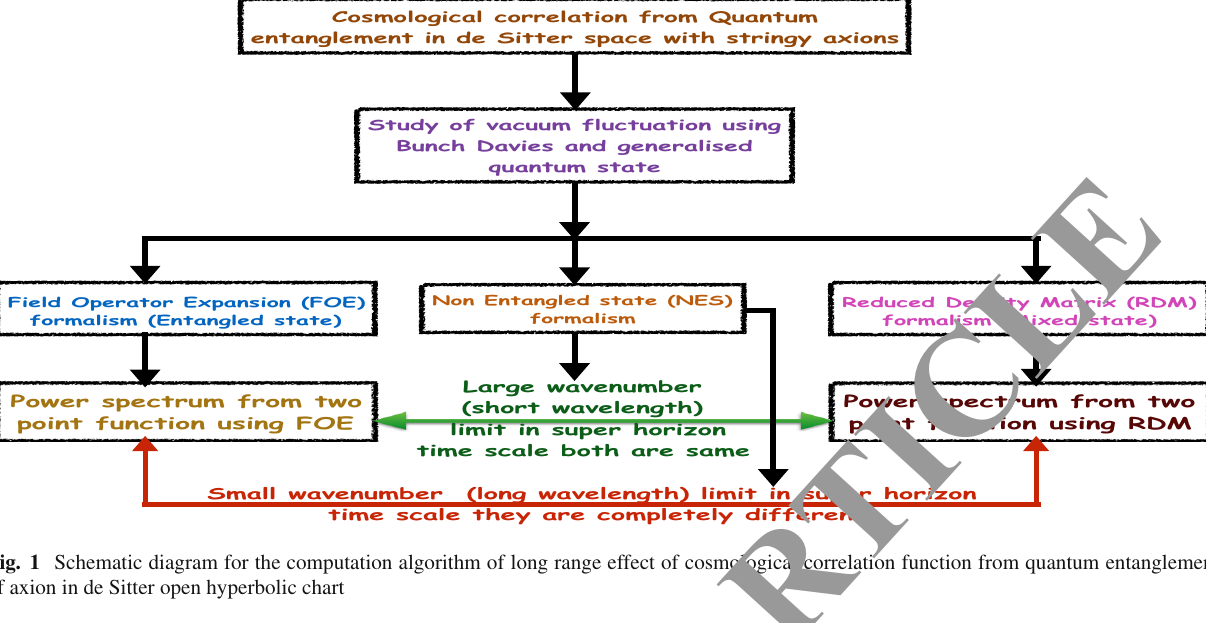
Fig. 1 Schematic diagram for the computation algorithm of long range effect of cosmological correlation function from quantum entanglement of axion in de Sitter open hyperbolic chart